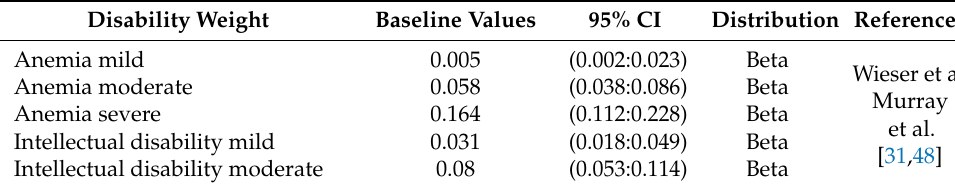
Table A2. Measurement on the impact of IDA in quality of life (disability weights).